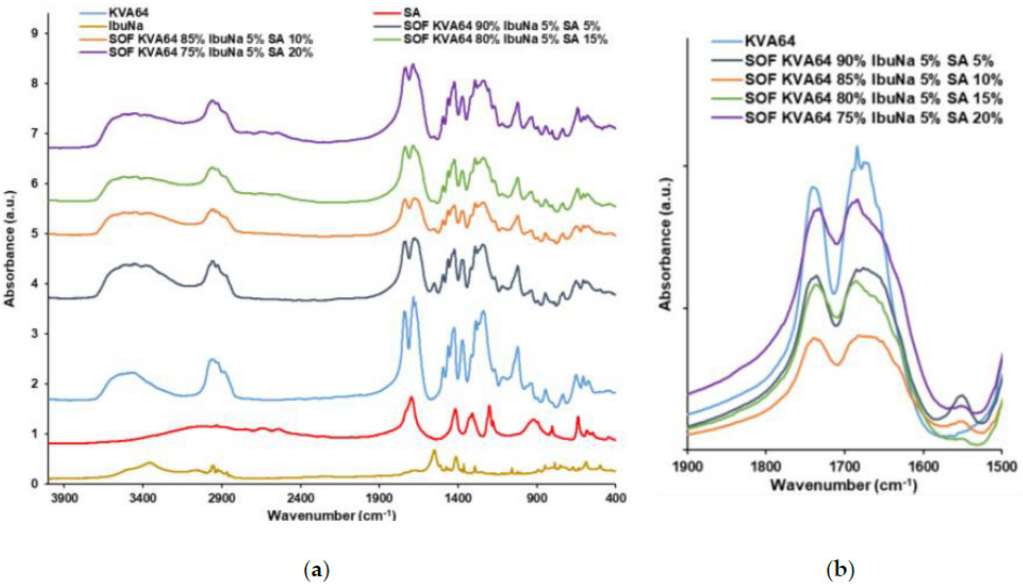
Figure 6. FTIR spectrums of KVA64, SA, IbuNa and printed SOFs: ( a ) from 400 to 4000 cm − 1 , ( b ) from 1500 to 1900 cm − 1 . Overall, all the SOFs prepared with mixtures of KVA64, di-carboxylic acids and/or drugs display interactions especially at the wavenumber 1683 cm -1 , which corresponds to the C=O amide peak of copovidone. This group is more reactive and more susceptible to form H-bonds than the C=O vinyl acetate function, as previously reported by Yuan et al . [53]. Although no change in frequency has been observed, variations in the width and intensity could also be interpreted as the formation of intermolecular hydrogen bonds [46]. The decrease in the intensity and the width of the C=O amide peak may indicate that the interactions between the copovidone molecules are being replaced by interactions be- tween the polymer and the other SOFs components. Nevertheless, the FTIR data did not allow differentiation between the distinct components in terms of plasticization. For in- stance, all of the di-carboxylic acids and drugs exhibited interactions, despite having a different effect on the optimal heating temperature. Moreover, as the proportion of suc- cinic acid increased, there was no proportional broadening of the peak (Figure 5b and Figure 6b). For the IbuNa, even with an absence of H-bond donors in its structure, interactions were found with the C=O group of KVA64. This may be due to the important moisture content present in the ibuprofen sodium salt that could participate in H-bond formation [54]. As noted by Matet et al . [55], FTIR is not a discriminatory technique and could not reveal differences between the different polymer/plasticizers mixtures. Moreover, the high hygroscopicity of copovidone [56] and the overlapping of the peaks are limits for the interpretation of FTIR results. H-bonds are temporary bonds that could evolve as function of the applied temperatures [57]. Hence, further work could involve conducting FTIR at the temperatures of the heating process [58] to mimic the interactions between the com- ponents under real sintering conditions. 3.3. Solid State Analysis XRPD analysis was carried out to study the solid state of the different components and the potential solid-state transitions due to the sintering process. All the used materials are crystalline except copovidone which is amorphous and did not expose any crystalline peaks on XRPD. X-ray diffractograms of drugs (Figure 7a) display the characteristic crys-